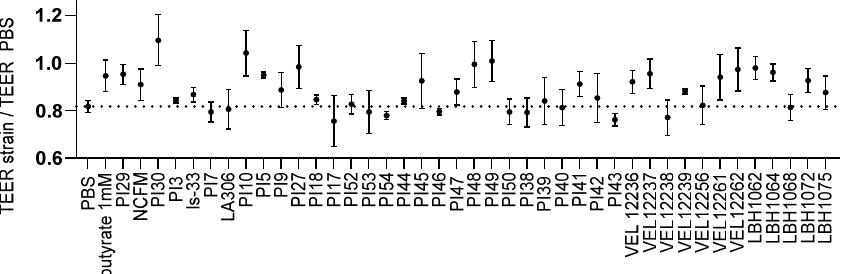
Figure 5. Effect on permeability in TNF- α stimulated Caco-2 cells. The evolution of TEER of the tested strain compared to the evolution of TEER with PBS only is expressed as a ratio. The control was PBS (the ratio of PBS is equal to 0.81; dotted line). A ratio above that of PBS means a protective effect on the barrier. Each strain was tested with 3 independent cultures (3 biological replicates) in technical duplicates. Data are shown as mean ± SEM.